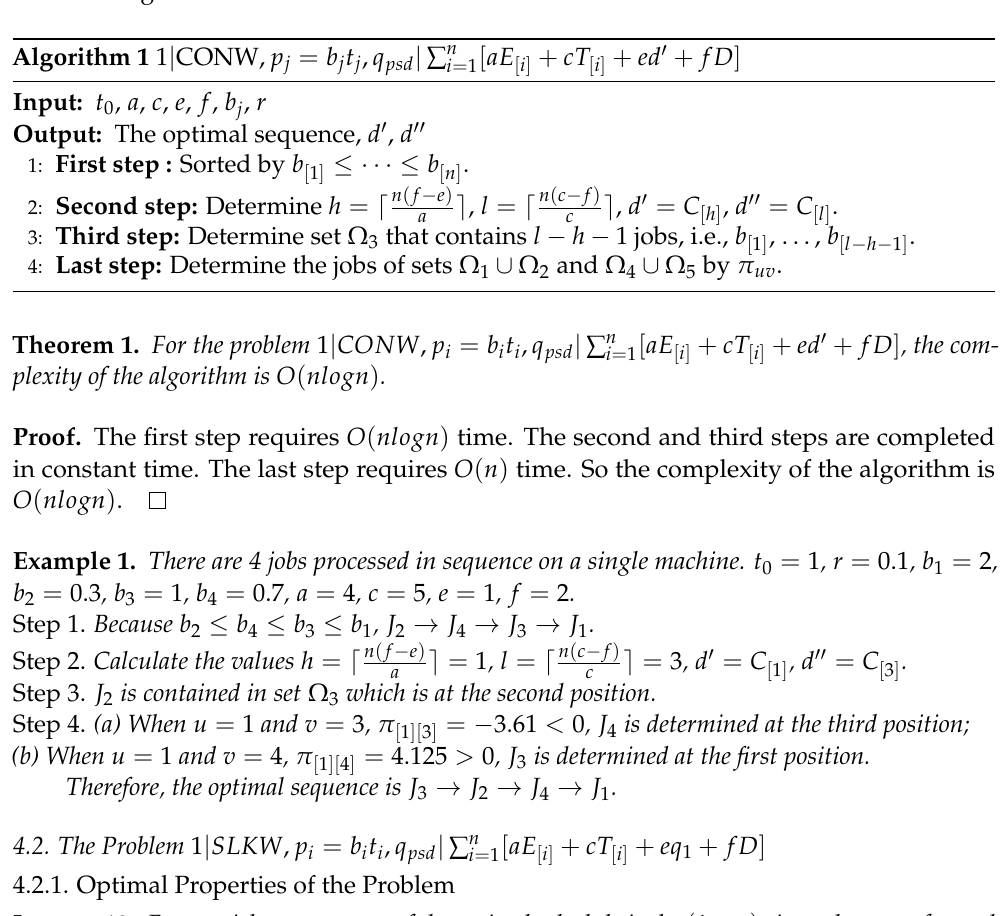
[ aE + cT + ed (cid:48) + f D [ i ] [ i ] i = 1